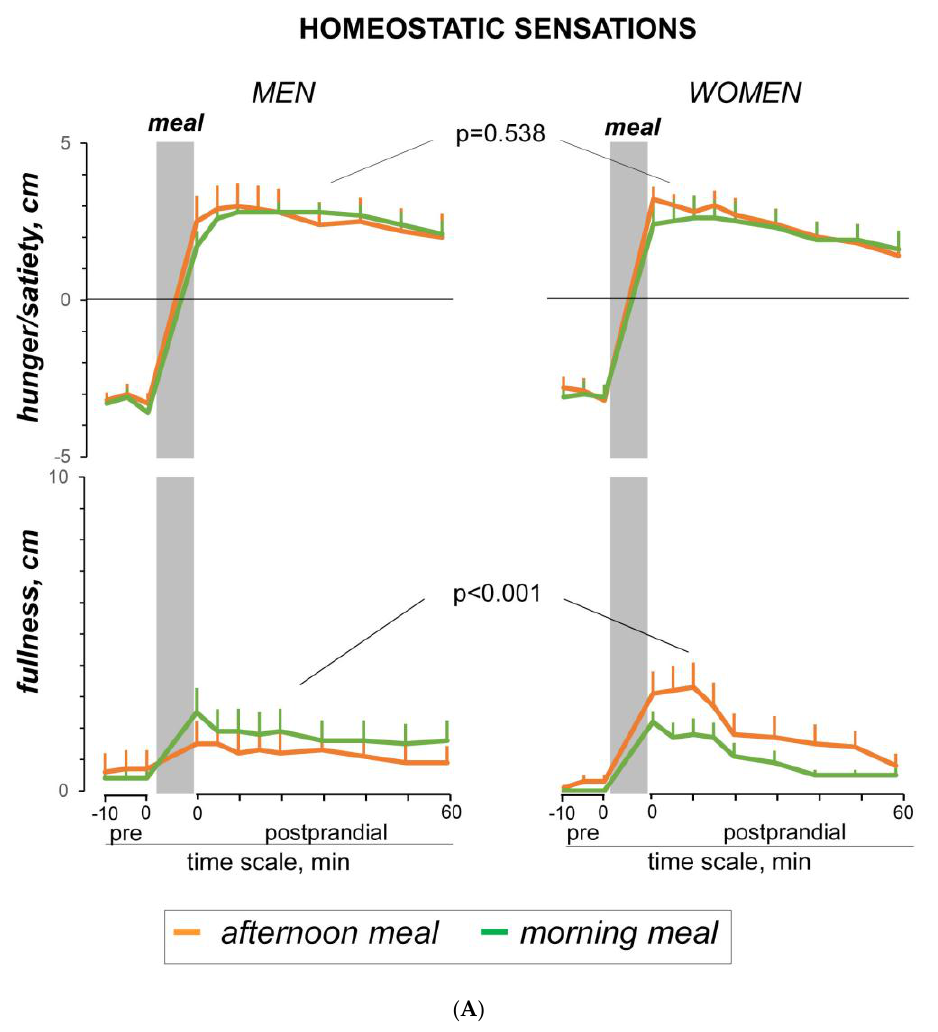
Figure 1. The effect of ingestion time on the postprandial experience. A. Homeostatic sensations. B. Hedonic sensations. Perceptions measured on 10-cm scales before (−10 to 0 minutes) and after (0 to 60 minutes) the meal; ingestion time 12 min. In women, the sensory experience induced by